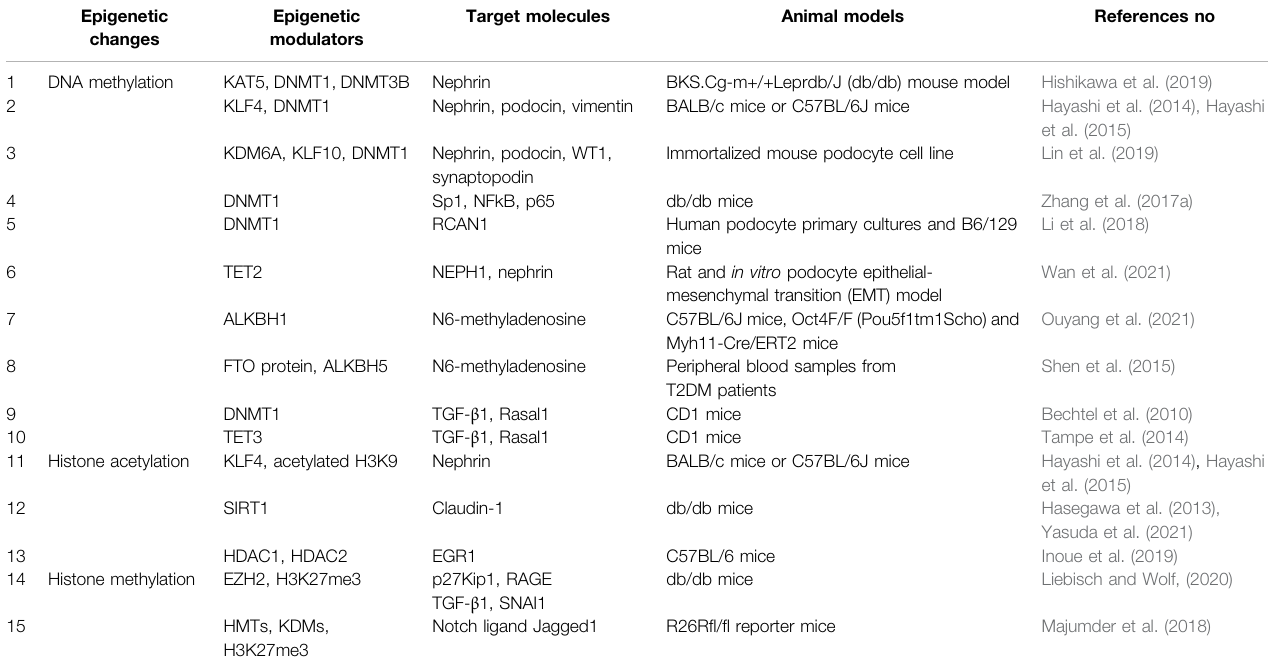
TABLE 1 | Summary of the animal studies regarding epigenetic changes in podocytes in